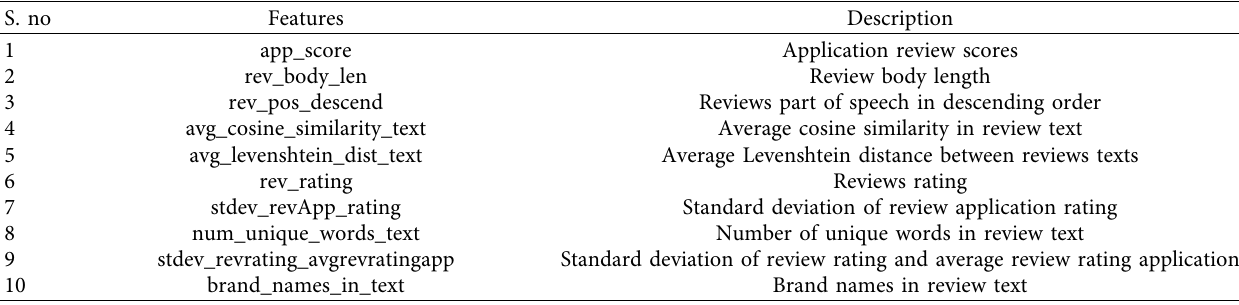
Table 4: Ten best features selected by Univariate for Yelp